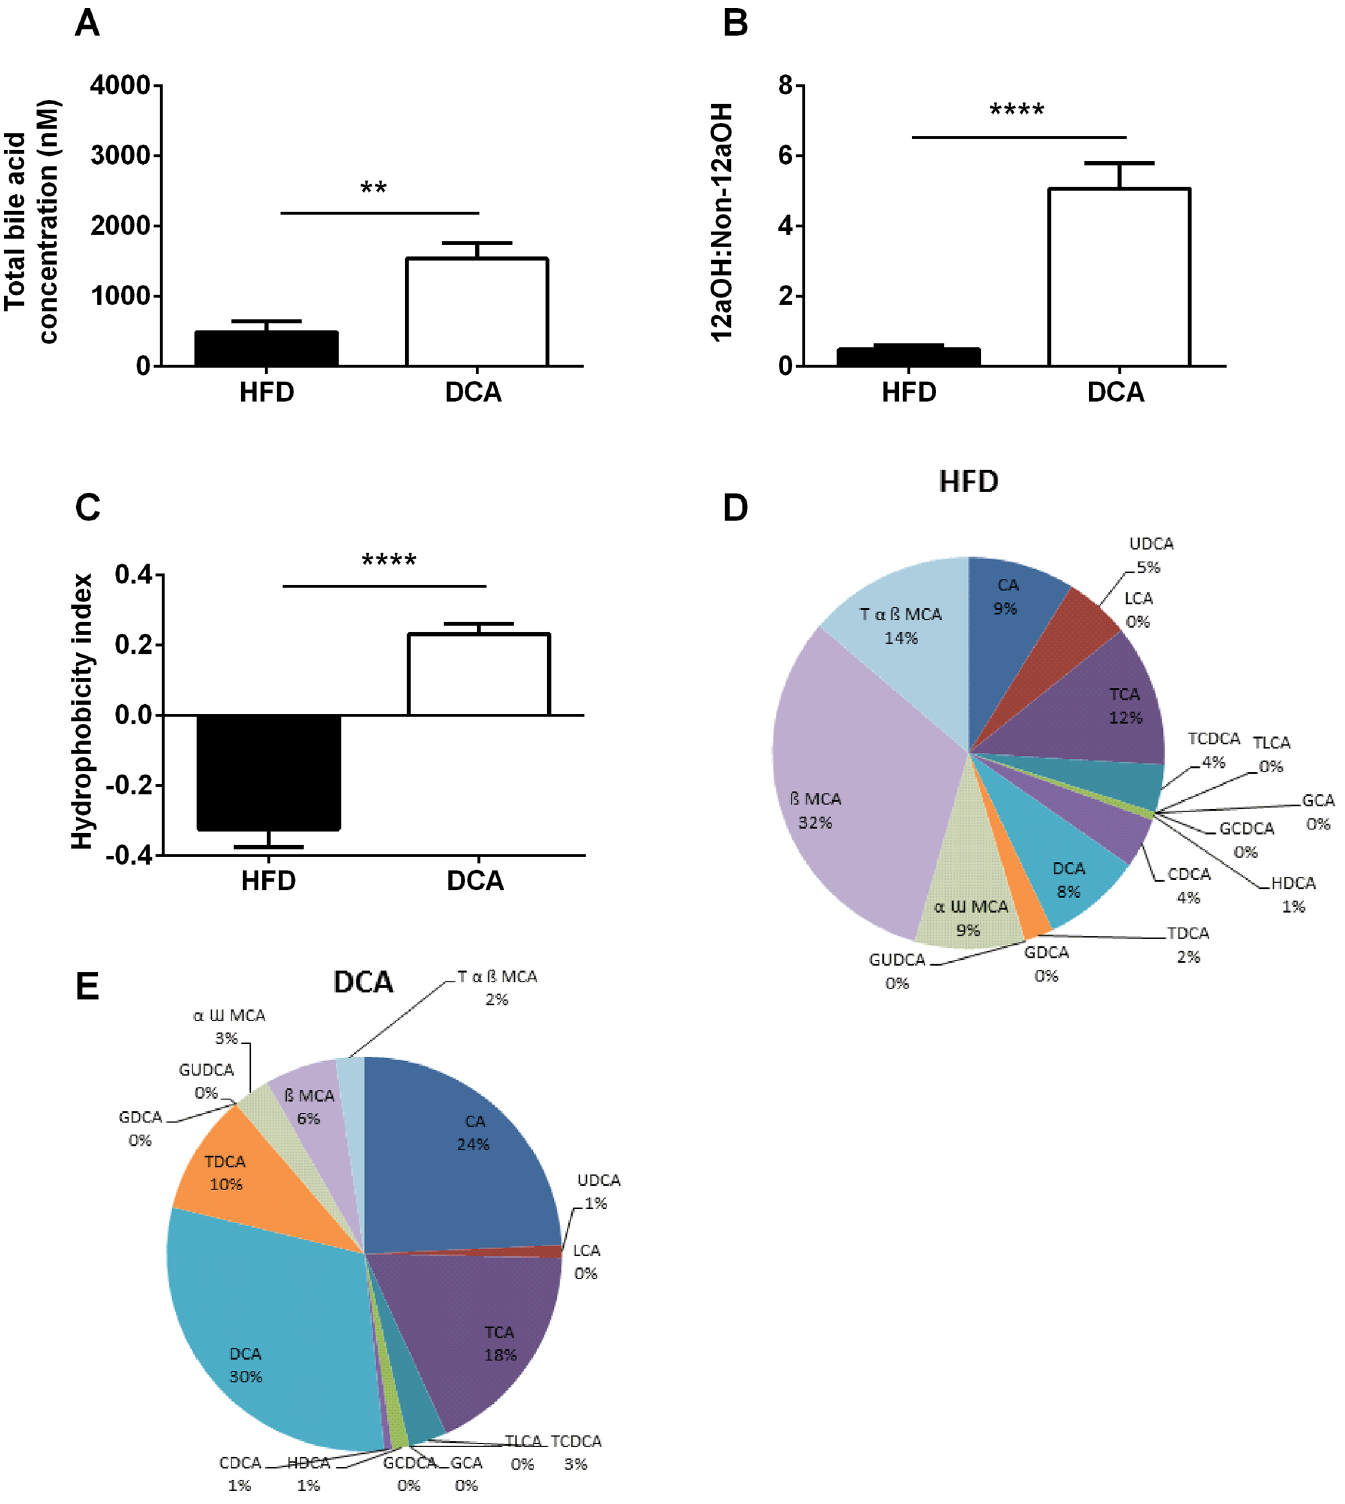
Fig 2. Fasting serum bile acid profile. Total bile acid concentration (A), 12 α OH:non-12 α OH ratio (B) and hydrophobicity index (C) in fasting serum samples. Relative proportions of bile acid subtypes in fasting serum samples from HFD (D) and DCA treated (E) mice. Data are expressed as mean ± SEM, (cid:3)(cid:3) P < 0.01, (cid:3)(cid:3)(cid:3)(cid:3) P < 0.0001 by Student’s t-test, n = 6 per group. TCA, taurocholic acid; TLCA, taurolitocholic acid; HDCA, hyodeoxycholic acid; GUDCA, glycoursodeoxycholic acid; CDCA, chenodeoxycholic acid; UDCA, ursodeoxycholic acid; α ωMCA, α ω muricholic acid; β MCA, β -muricholic acid and T αβ MCA, tauro- αβ muricholic acid.